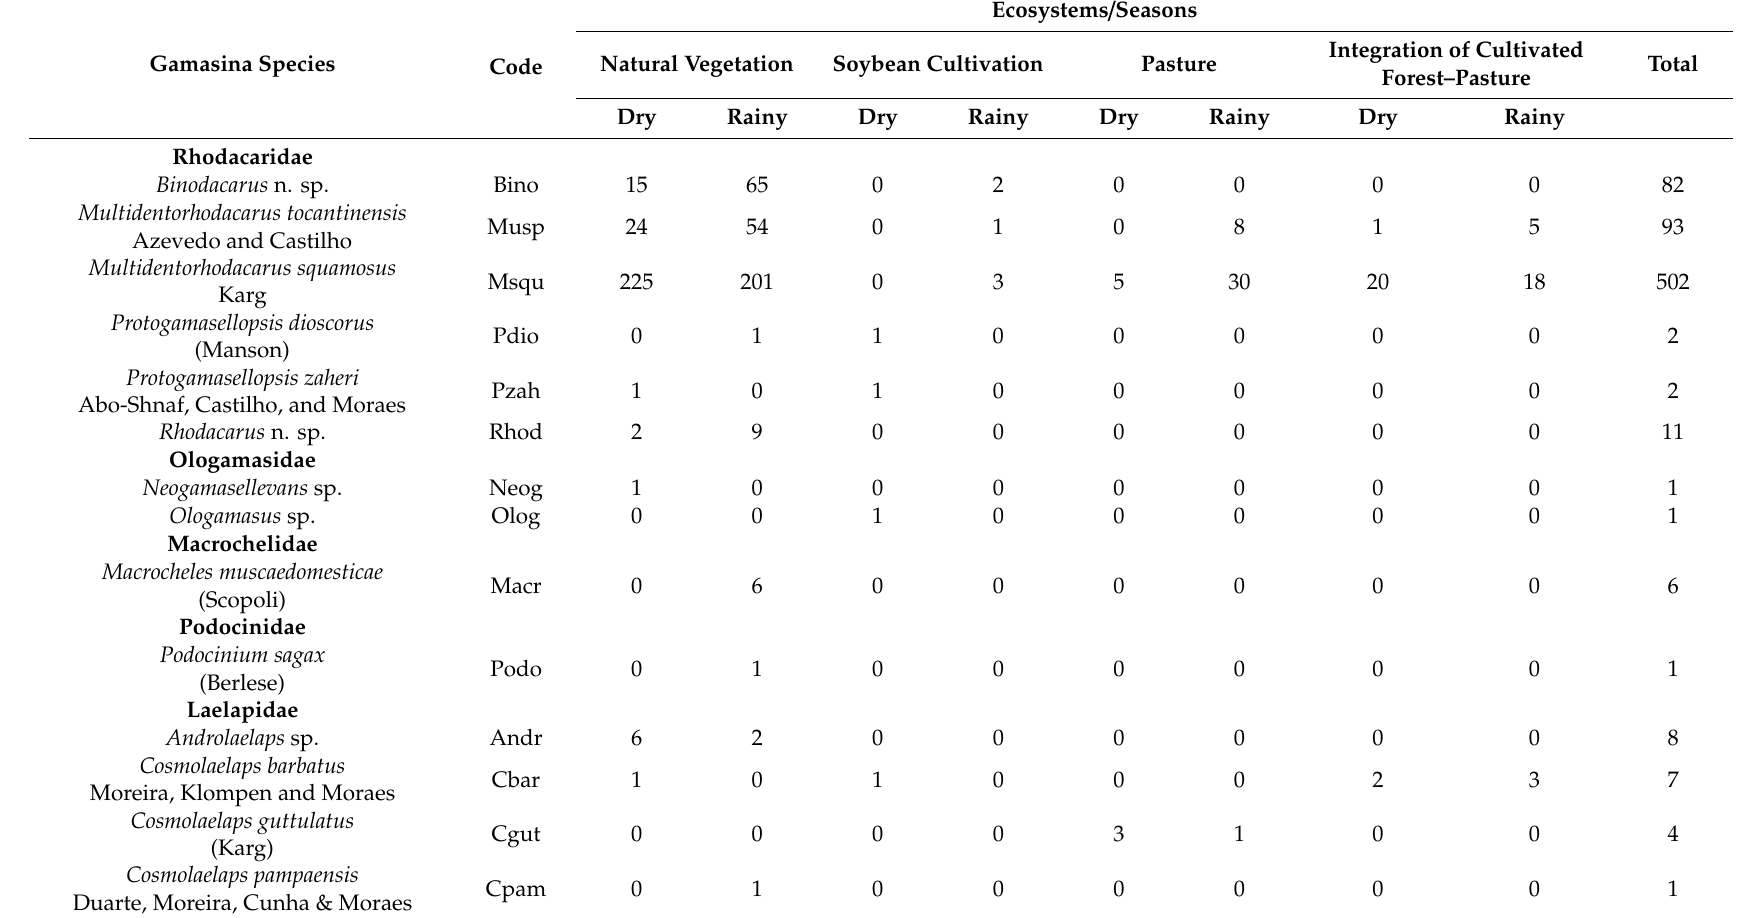
Table 2. Gamasina mites from soil samples collected at four ecosystems in Sucupira, Tocantins, Brazil, in the dry (July–October 2015 and May–June 2016) and rainy season (November 2015–April